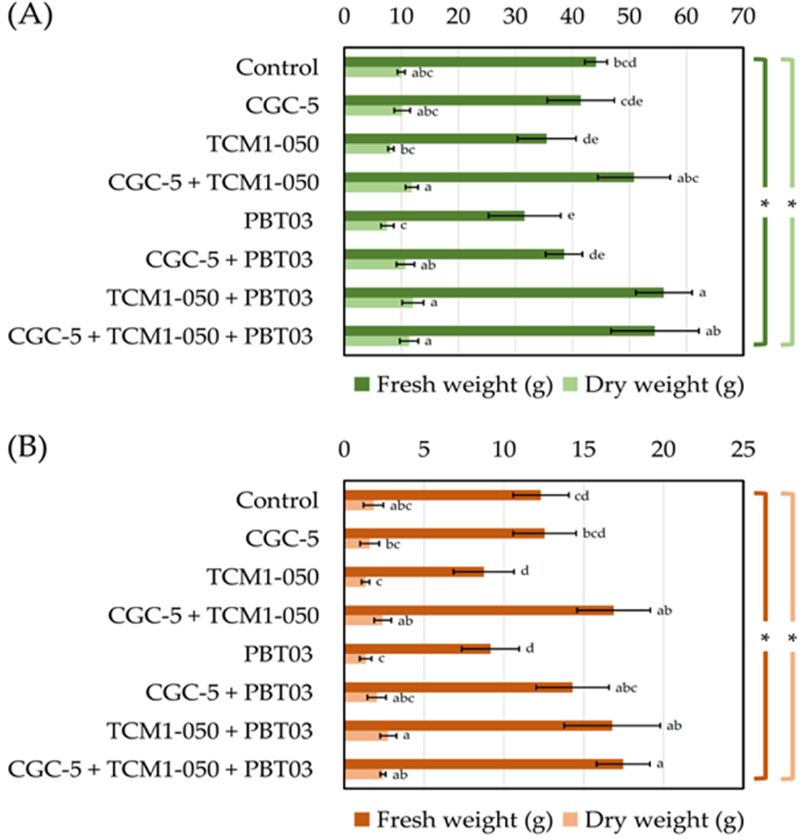
Figure 4. Impacts of teak rhizosphere microbes on fresh and dry weights of teak seedlings’ stems ( A) and roots ( B ). Different treatments were established, including a non-inoculated control and those inoculated with Agrobacterium sp. CGC-5, Kitasatospora sp. TCM1-050, Claroideoglomus sp. PBT03, or different consortia of these microbes. The experiments were done in five replicates. Small case letters refer to the statistical difference of means compared by one-way ANOVA at α = 0.05. The statistical results comprise of ( A ) fresh ( F (7, 32) = 13.40, p ≤ 0.0005) and dry ( F (7, 32) = 7.83, p ≤ 0.0005) weights of teak stems and ( B ) fresh ( F (7, 32) = 13.05, p ≤ 0.0005) and dry ( F (7, 32) = 6.00, p ≤ 0.0005) weights of teak roots. The asterisk remark indicates the statistical significance.